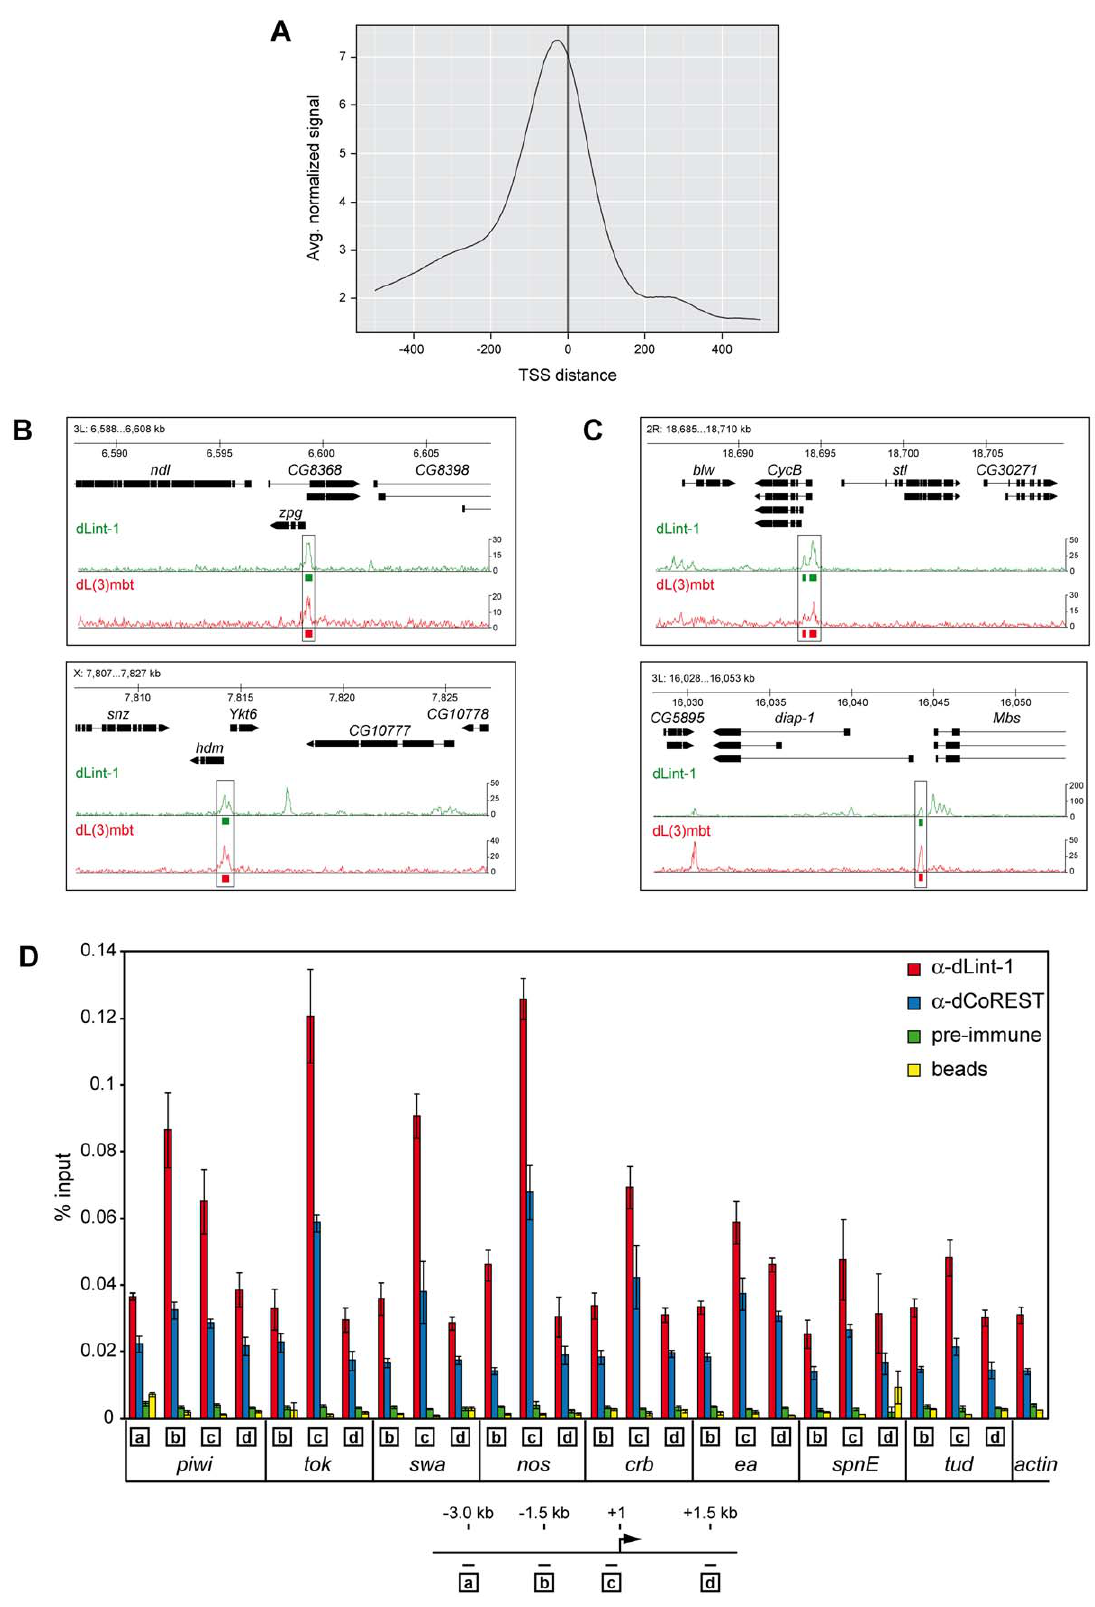
Figure 4. LINT binds to genes deregulated in l(3)mbt ts brain tumours. (A) Averaged dLint-1 ChIPseq signal intensity around those transcription start sites that are within 1 kilobase of a dLint-1 peak (normalized to 1 million tags). In cases where multiple TSSs were within 1 kb of a peak, the one with the smallest summit-TSS distance was chosen. (B) Genome browser view of dLint-1 and dL(3)mbt [4] chromatin association in